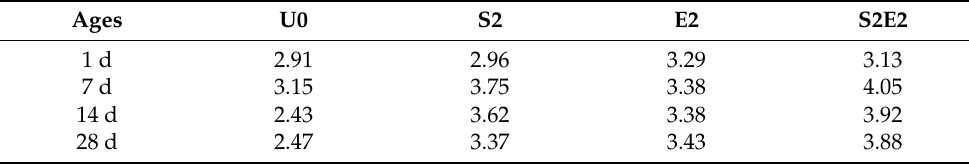
Table 7. Calcium hydroxide amount in the UHPC matrix